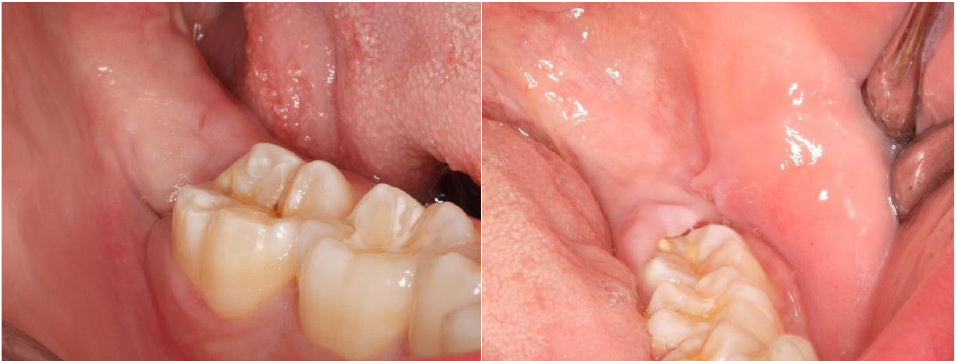
Figure 9. A case example of a patient’s follow -up, 2 weeks after surgery. On the left, the result of tooth extraction where chitosan was applied to the socket; on the right, the side subjected to surgery with chitosan application.